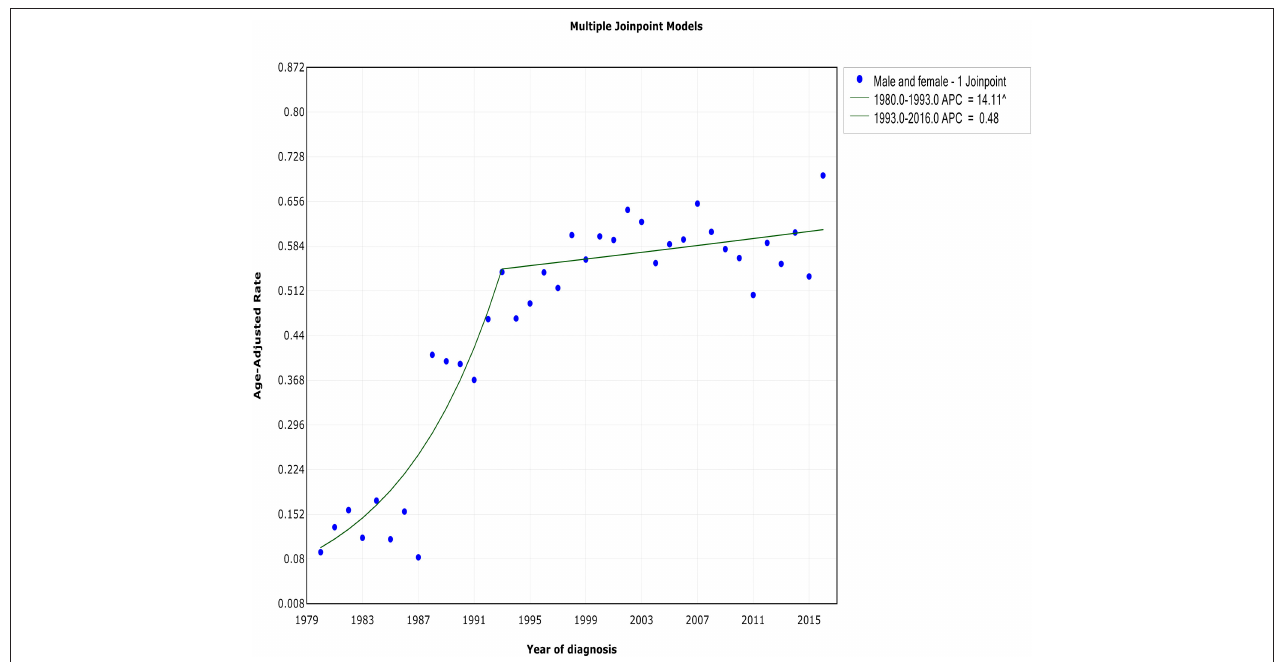
FIGURE 1 | The overall trends in the incidence of Waldenström